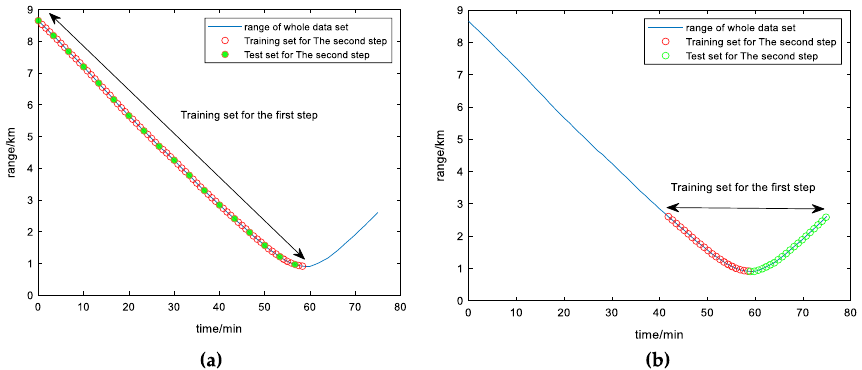
Fig. 8 Dataset division method: a The first type of dataset division; b the second type of dataset